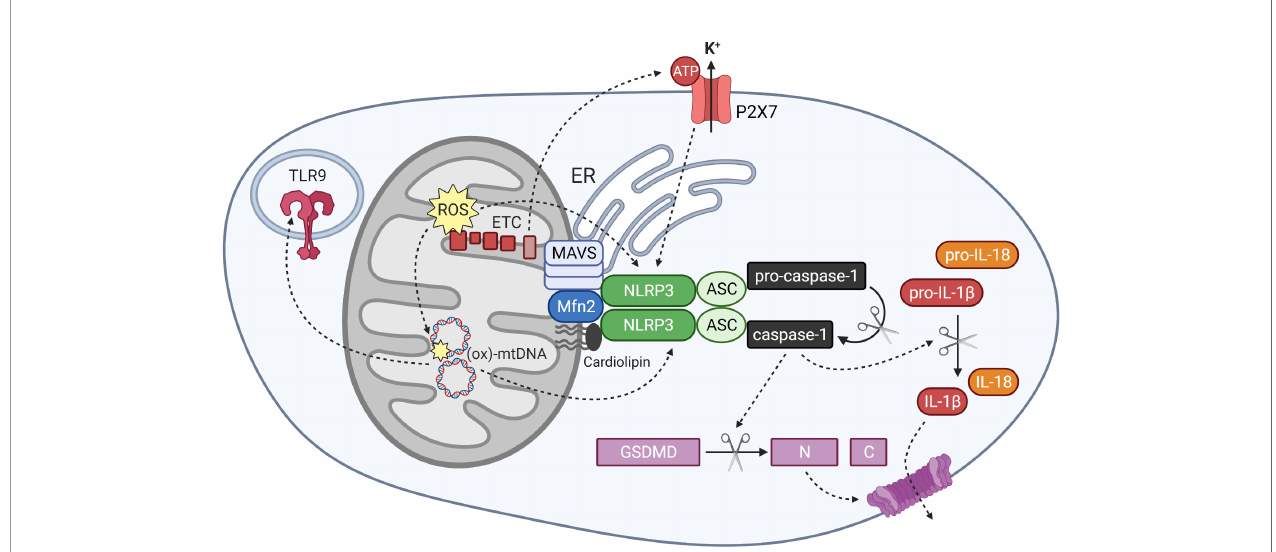
FIGURE 3 | Mitochondrial regulation of NLRP3 in fl ammasome activation and mitochondrial DAMP activity. The NLRP3 in fl ammasome is activated by signals including mitochondrial reactive oxygen species (ROS), oxidised mitochondrial DNA (ox-mtDNA) and potassium ef fl ux through the ATP-gated channel P2X7. Components of the in fl ammasome localise to mitochondrial and ER membranes upon activation, where they associate with MAVS, Mfn 2 and cardiolipin in the outer mitochondria membrane. Oligomerised NLRP3 and its adapter protein ASC recruit and activate caspase-1, which cleaves gasdermin D and interleukin-1 family cytokines into their active forms. Ox-mtDNA also exhibits DAMP activity by stimulating other pattern recognition receptors including the endosomal toll-like receptor